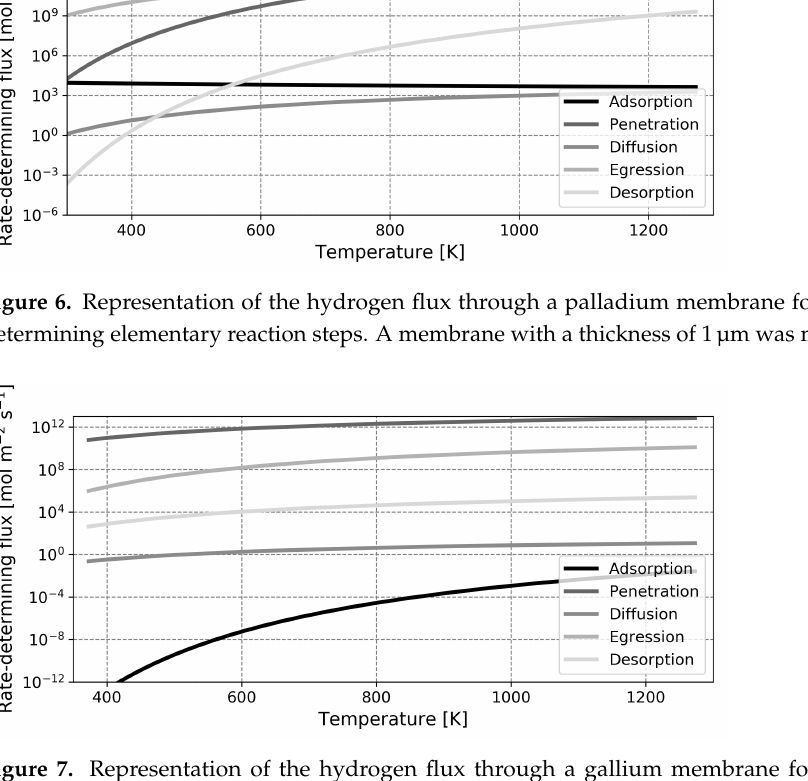
Figure 7. Representation of the hydrogen flux through a gallium membrane for different rate- determining elementary reaction steps. A membrane with a thickness of 100µm was